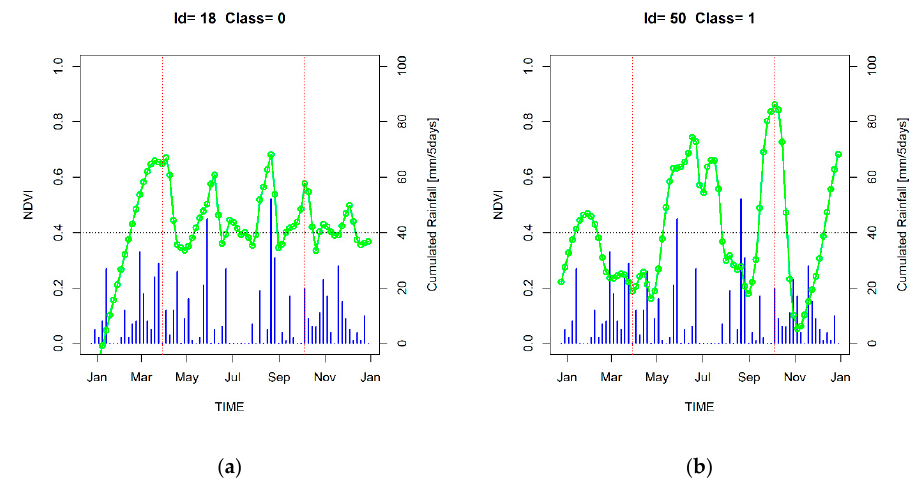
Figure 6. NDVI time series and accumulated rainfall data at pixel scale. Example of ( a ) class 0 (rainfed and bare soil) in phase and ( b ) class 1 (herbaceous) not in phase.